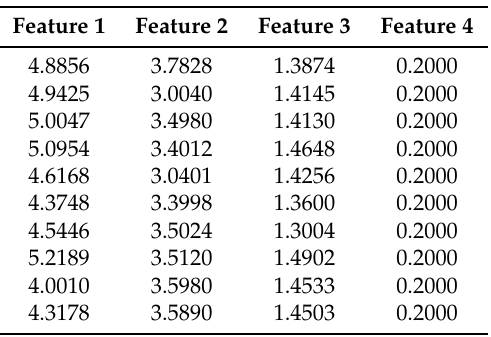
Table 10. Ten virtual samples (A).